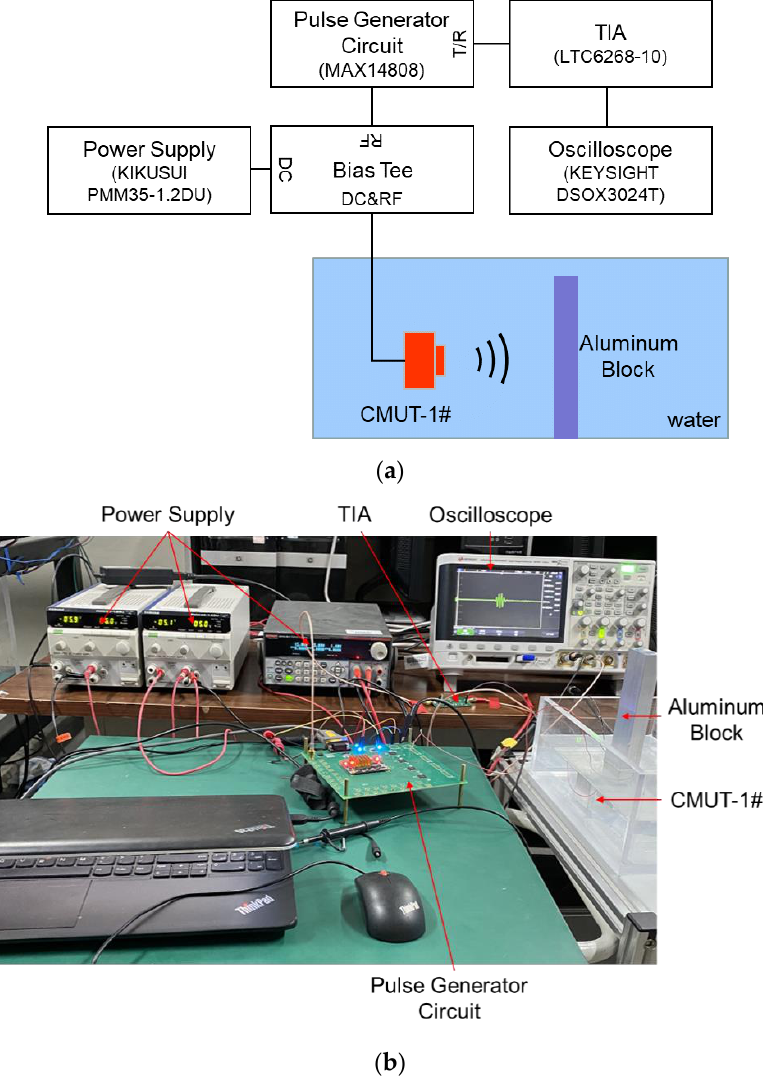
Figure 10. ( a ) Schematic of the measurement setup of the CMUT pulse-echo signal; ( b ) photograph of the measurement setup.